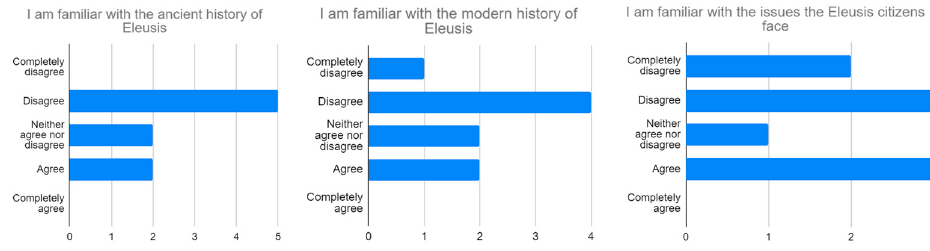
Figure 5. Familiarity of the participants with the city of Eleusis before the start of the tour.